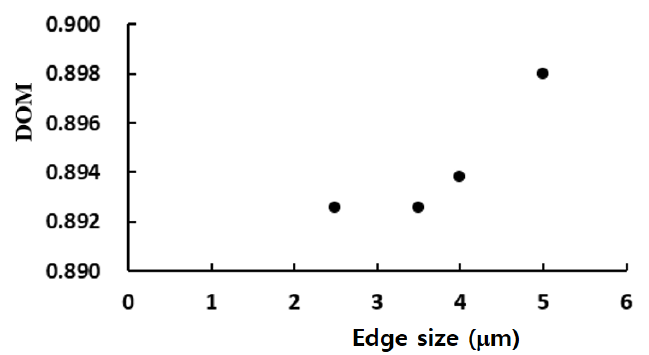
Figure 5. Dependence of the numerical solution on the edge size.